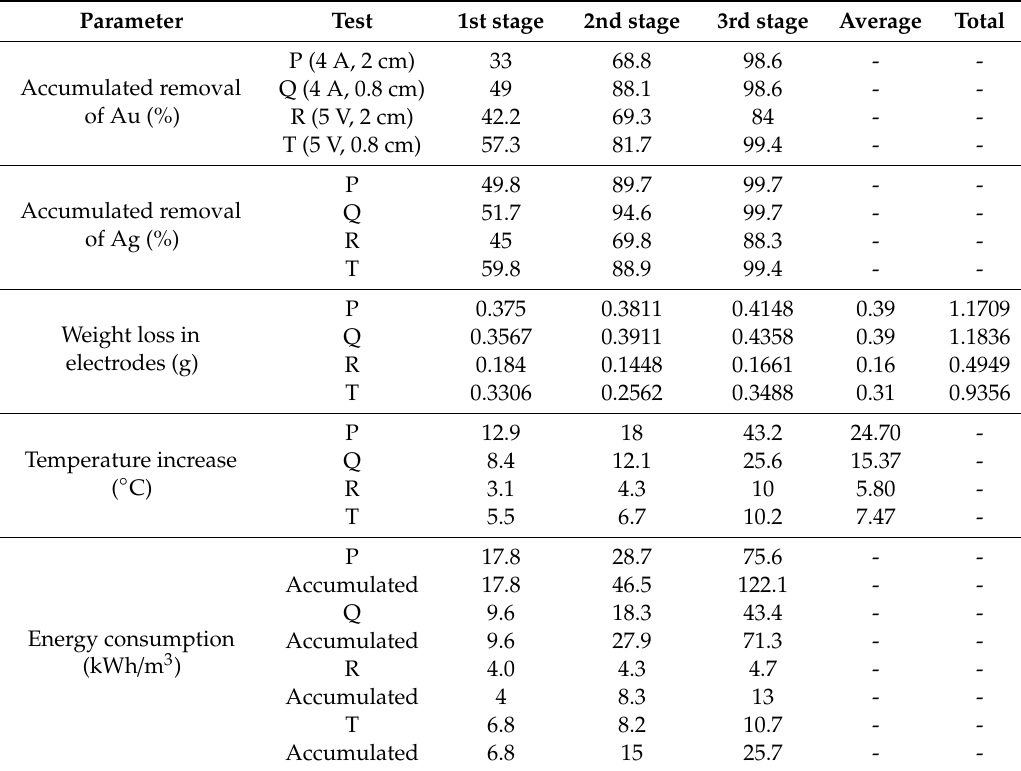
Figure 6. Graph of concentration versus t, in test T.